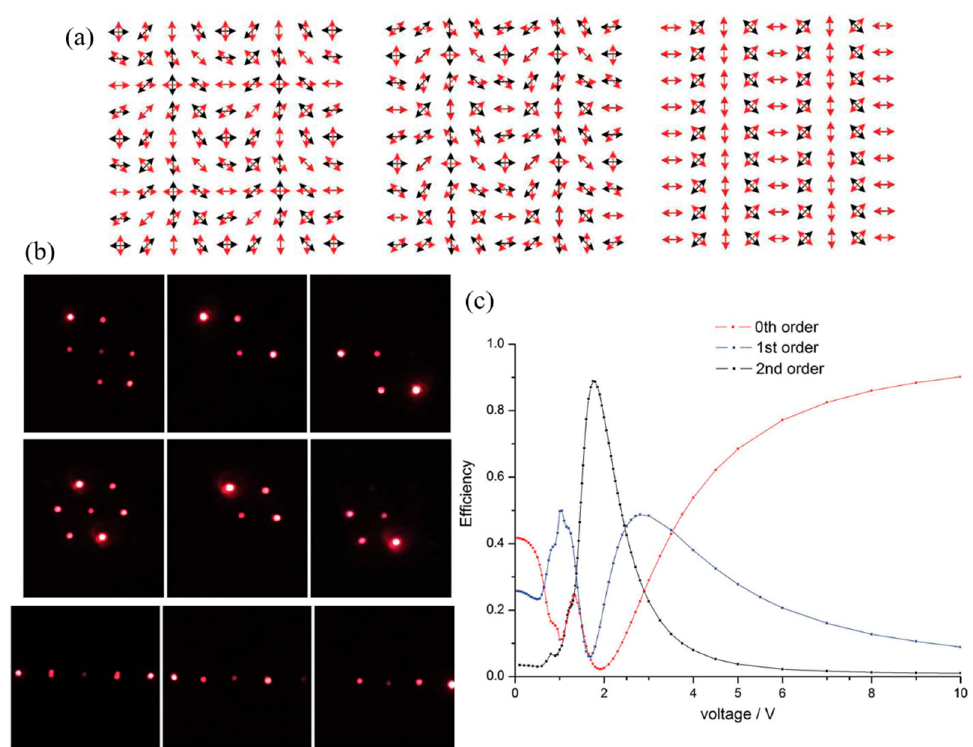
Figure 2. ( a ) Structures of 2D LC PGs by assembling two 1D polarization patterns with crossing angle of π /2, 3 π /4 and π , respectively. ( b ) Diffraction images of the corresponding structures from top to bottom with (left) LP, (middle) left CP (LCP) and right CP (RCP) incident beams. ( c ) The diffraction efficiency as a function of the applied ac voltage with a LCP probe beam for the sample with a π crossing angle. Reproduced from Reference [31] with permission from Taylor & Francis.